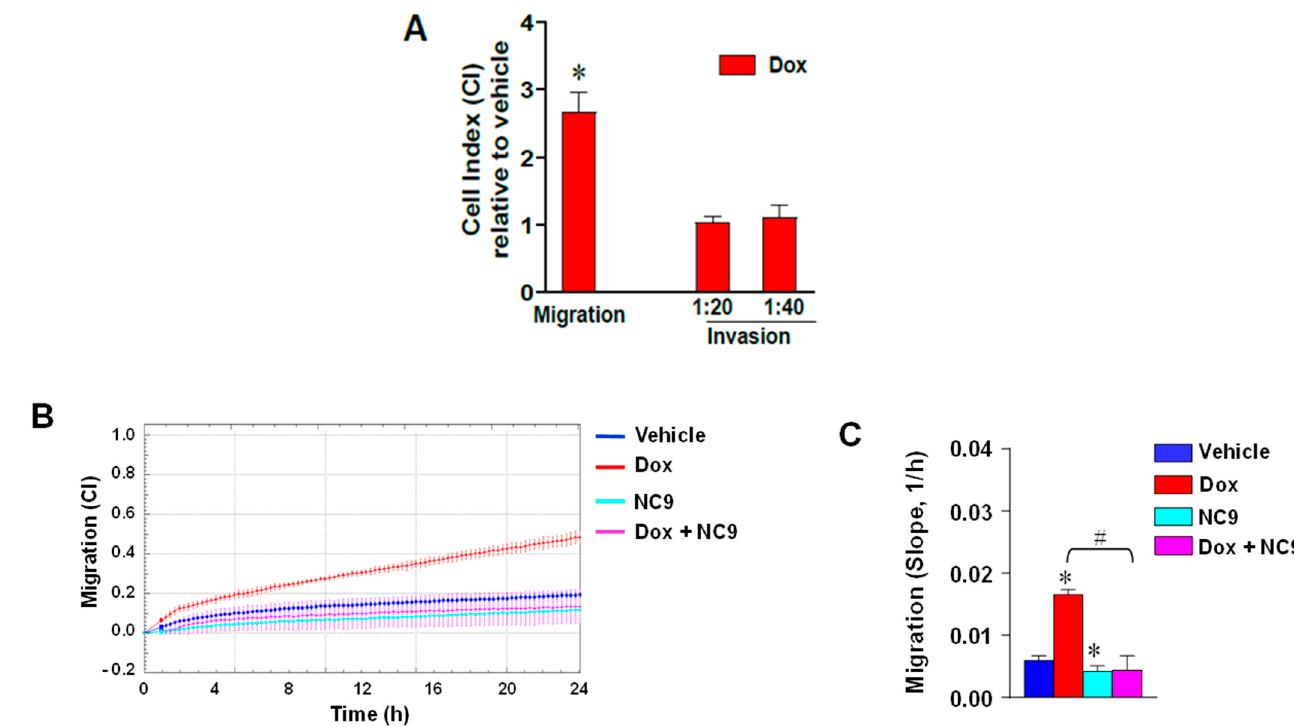
Figure 2. ( A ) xCELLigence-driven dynamic monitoring of migration and invasion through diluted matrigel (1:20 and 1:40) of MCF-7 cells cultured in the presence or absence of Dox for 36 h. Cell index (CI) values are reported relative to vehicle. ( B ) Dynamic monitoring of migration of MCF-7 cells cultured in the presence of Dox and/or NC9. Data are reported as CI ± SD. ( C ) The correspondent slope analysis that describes the steepness, inclination, gradient, and changing rate of the CI curves over time is shown. All of the data are shown as the mean of three independent experiments performed in triplicate ± SD. * p < 0.05 versus vehicle; # p < 0.05 between bars.